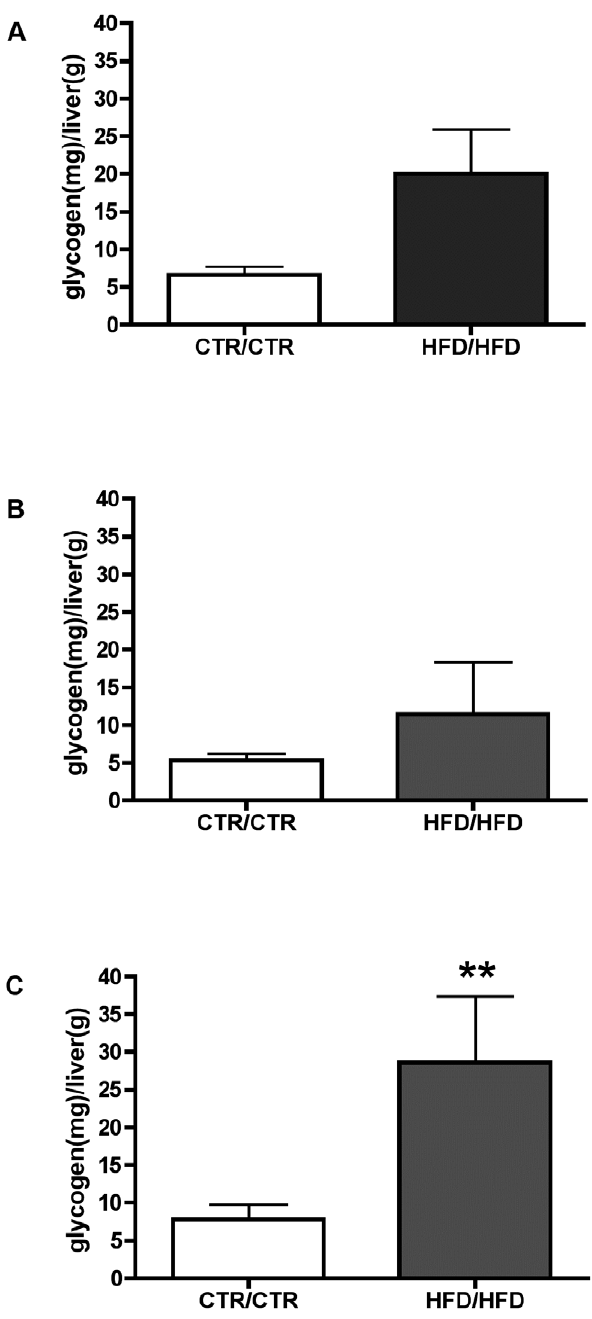
Figure 5. Quantification of hepatic glycogen content in the one-year old juvenile macaque. Quantification of hepatic glycogen between CTR/CTR and HFD/HFD diet groups (A). Quantification of hepatic glycogen in female juvenile livers between CTR/CTR and HFD/ HFD juvenile diet groups (B). Quantification of hepatic glycogen in male juvenile livers between CTR/CTR and HFD/HFD juvenile diet groups (C). CTR/CTR n=17, 9 males 8 females; HFD/HFD n=14, 7 males, 7 females. ( ** = p ,